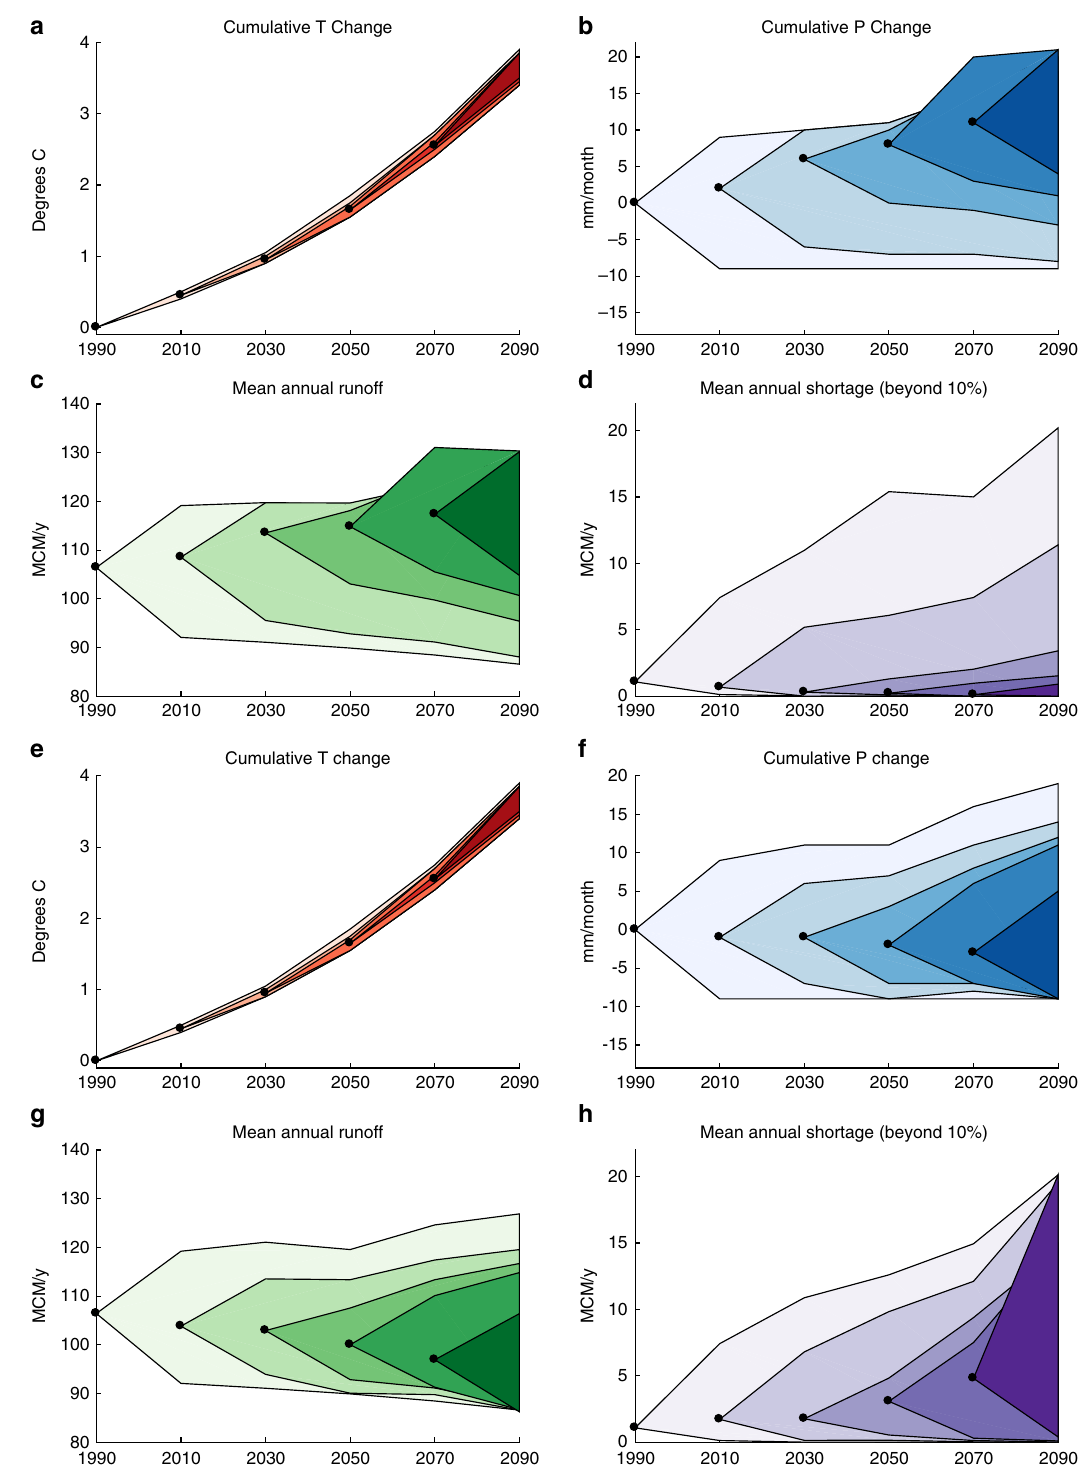
Fig. 3 Learning over time using virtual observations. a – d One sample realization of Bayesian learning over time in which precipitation increases strongly. Black dots represent a time series of virtual climate observations. Shaded regions indicate the projected 90% CI, updated with each time period ’ s virtual observation. Virtual observations of T ( a ) and P ( b ) are used to simulate MAR ( c ), and water shortages assuming 80 MCM dam capacity ( d ). e , h As